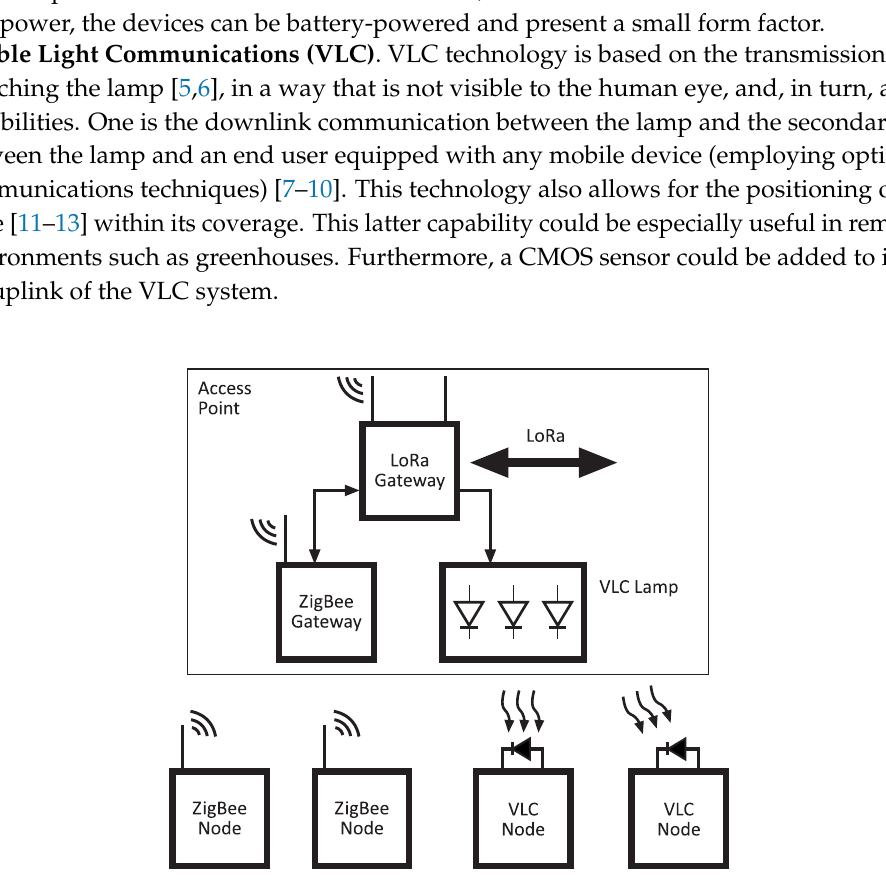
Figure 1. Cell communication between nodes using different